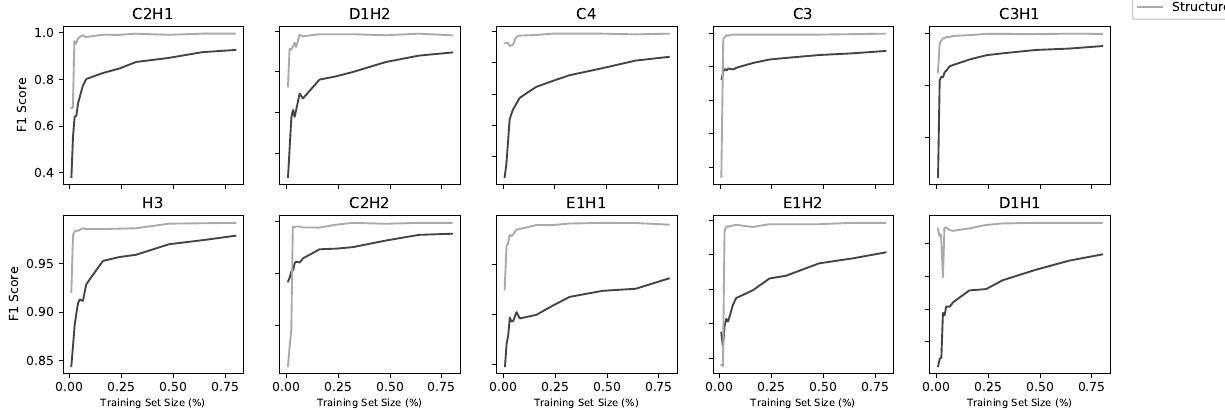
Figure 3. Learning curves for all 20 models (10 structural and 10 sequence). Each model was trained on increasing subsets of the overall training set using five-fold cross-validation. Sequence models improved with increasing dataset size whereas, above a low threshold, structure models did not improve with more